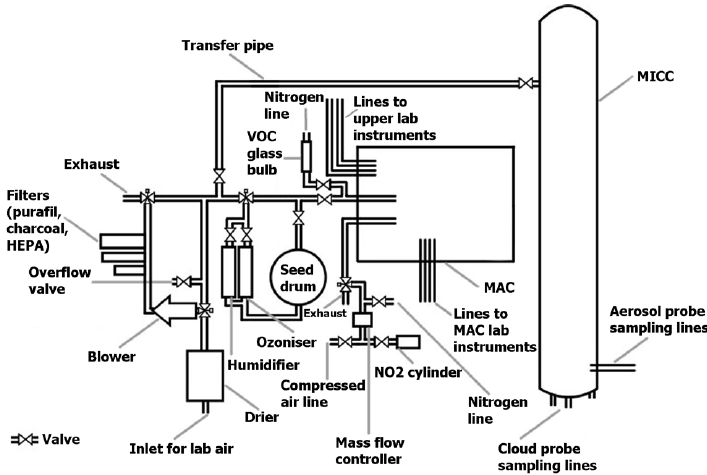
Figure 1. Drawing of the aerosol (MAC) and cloud (MICC) chambers, air system, connecting pipes, and various sampling